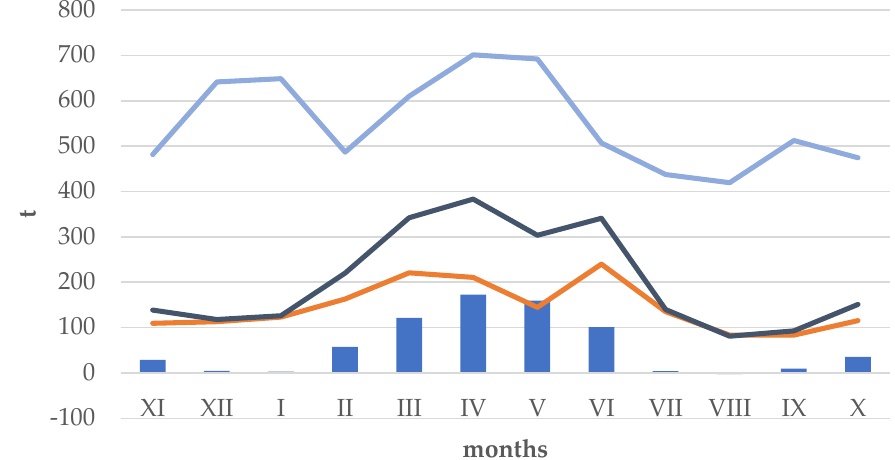
Figure 3. Total suspended sediment budget of Koronowski Reservoir during the hydrological year 2015. Explanations: inflowing suspended sediments (dark blue—2015; light blue—average 1980–2015 [47]); outflowing suspended sediments (orange) and suspended sediment balance (light blue columns).